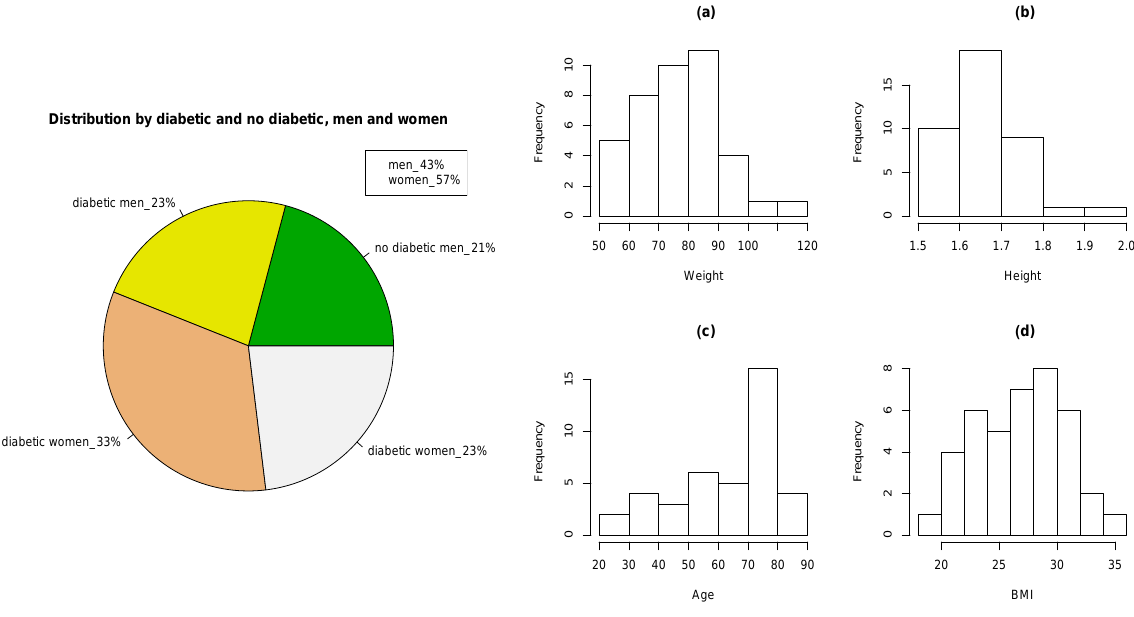
Figure 3. Data distribution ( left ) and Histograms for different variables ( right ): ( a ) Weight, ( b ) Height, ( c ) Age, and ( d )